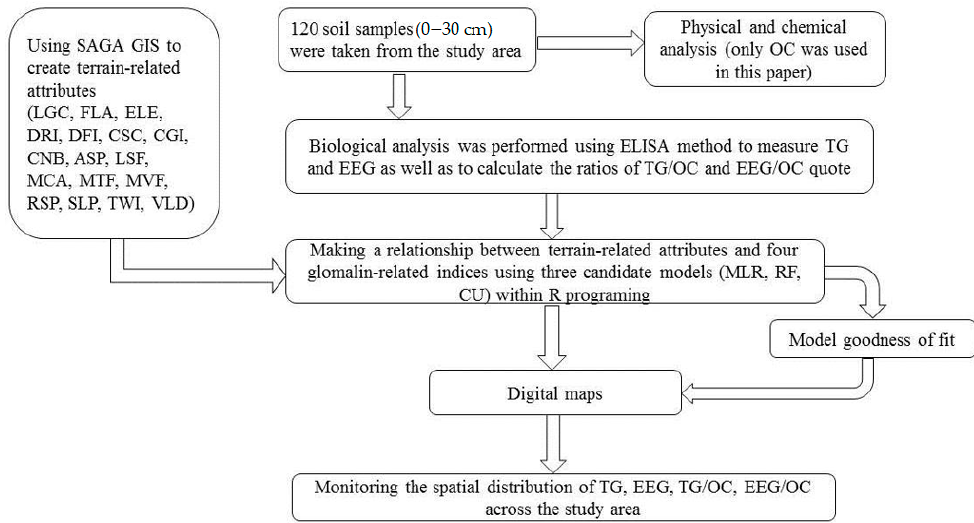
Figure 2. The general scheme of the procedure used in this experiment. LGC: longitudinal curvature; FLA: flow accumulation; ELE: elevation; DRI: direct insolation; DFI: diffuse insolation; CSC: cross-sectional curvature; CGI: convergence index; CNB: channel network base level; ASP: aspect; LSF: LS factor; MCA: modified catchment area; MTF: multi-resolution ridge top flatness; MVF: multi-resolution index of valley bottom flatness; RSP: relative slope position; SLP: slope; TWI: topographic wetness index; VLD: valley depth; OC: organic carbon; ELISA: enzyme-linked immunosorbent assay; TG: total glomalin; EEG: easily extractable glomalin; MLR: multiple linear regression; RF: random forests; CU: Cubist.